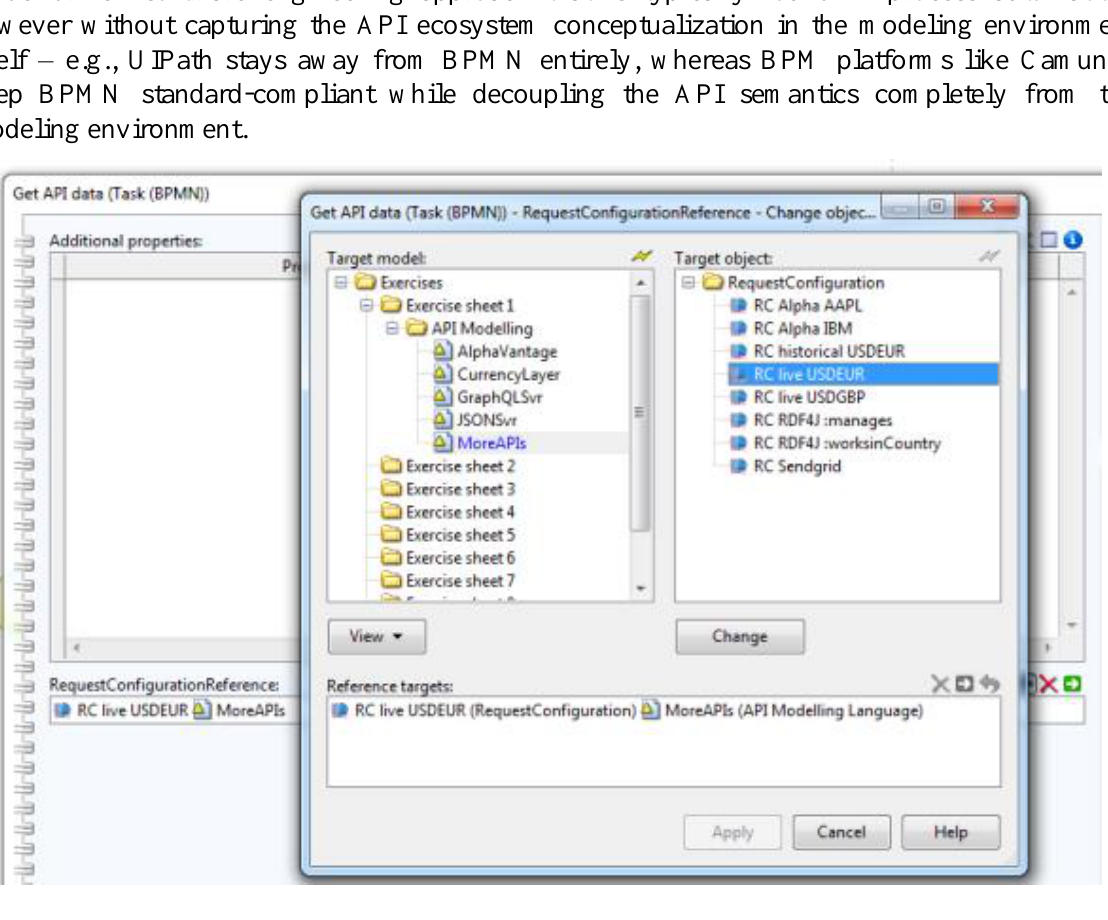
Figure 8. Semantic linking between a BPMN Task and a